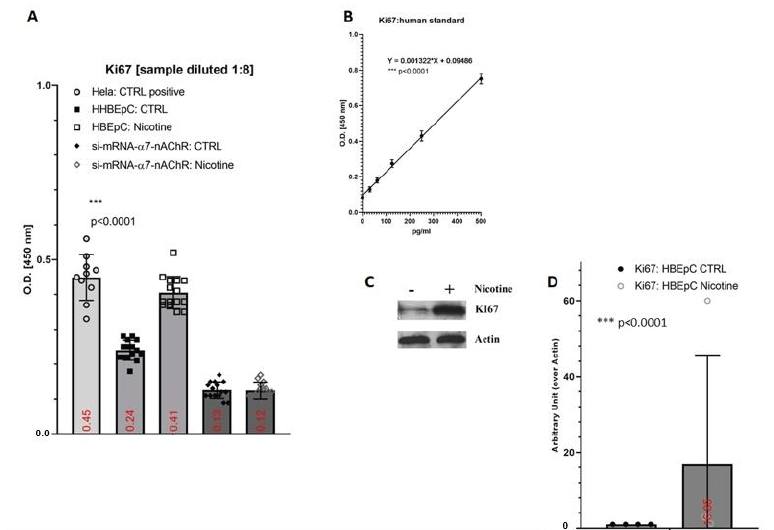
Figure 2. Expression of Ki67 induced by nicotine in HBEpC and/or si-mRNA- α 7-HBEpC. ( A ): ELISA experiments; ( B ): regression equation linearity, performed with Prism; ( C ): Western blotting, ( D ): densitometric analysis. Statistical significance is analyzed with one-way ANOVA with multiple- comparison and post hoc test with Bonferroni correction. Experiments are performed at least two times in triplicate. In the Supplementary Materials, raw data of Western blotting are